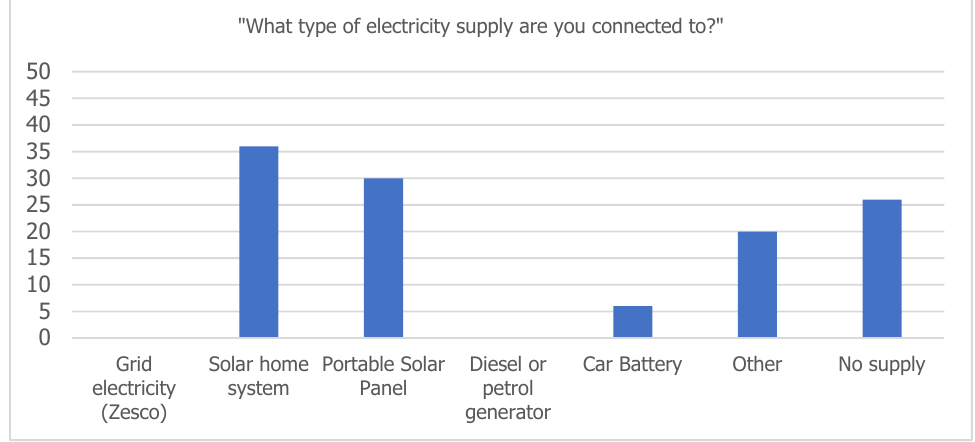
Figure A3. Type of electricity supply, Southern Zambia (Responses in %; Multiple Responses; N = 50).